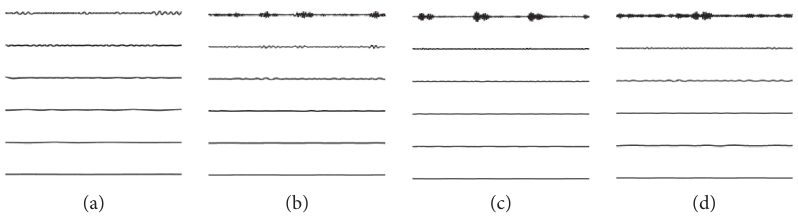
Figure 4: IMFA sample: (a) normal state; (b) inner ring fault; (c) outer ring fault; (d) rolling body